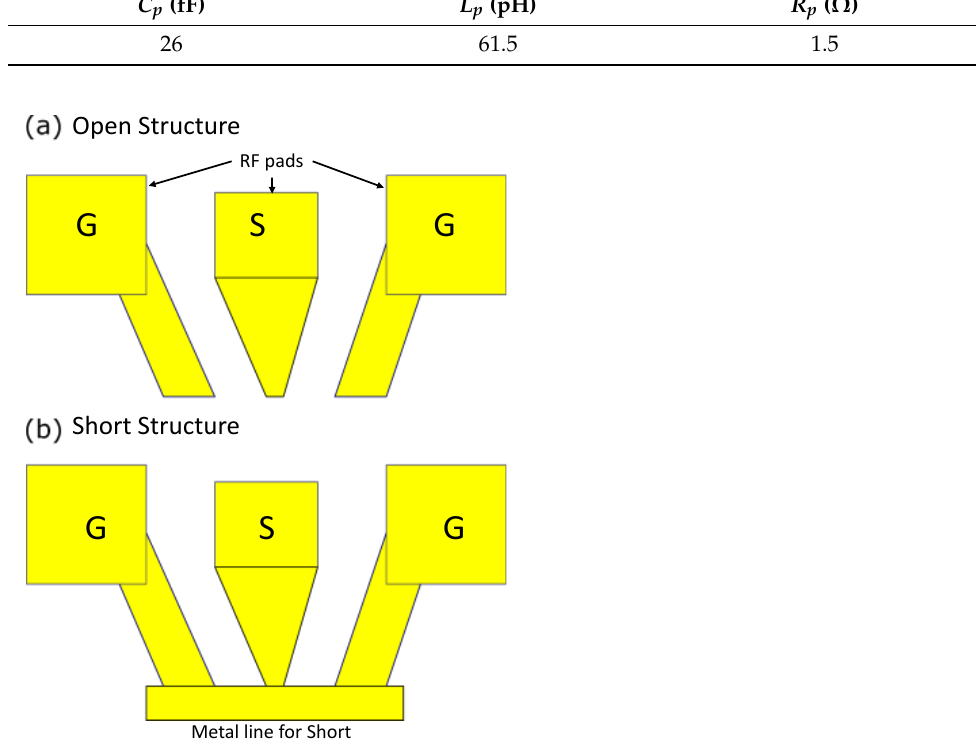
Figure 16. Measured S 11 for open (blue) and short (red) patterns. The average values of resistance R p , C p and L p extracted at high frequency are sum- marized in Table 4. Table 4. Extracted parameter values of the UTC-PD de-embedding test structures. C p (fF)